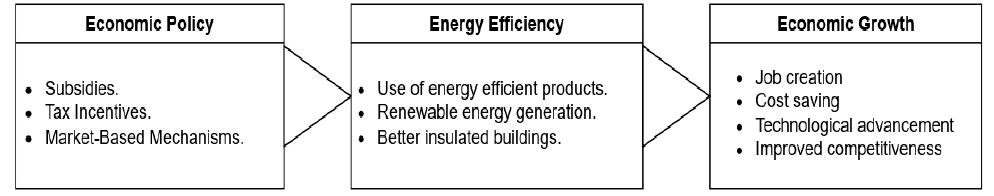
Figure 1. Theoretical framework of energy efficiency and economy. Source: Own elaboration.